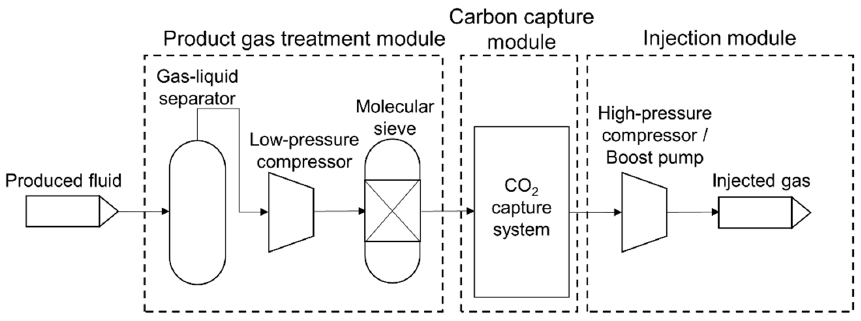
Figure 3. Main equipment units involved in the simplified CCRP. Table 1. Main equipment units involved in the five types of CCRPs.